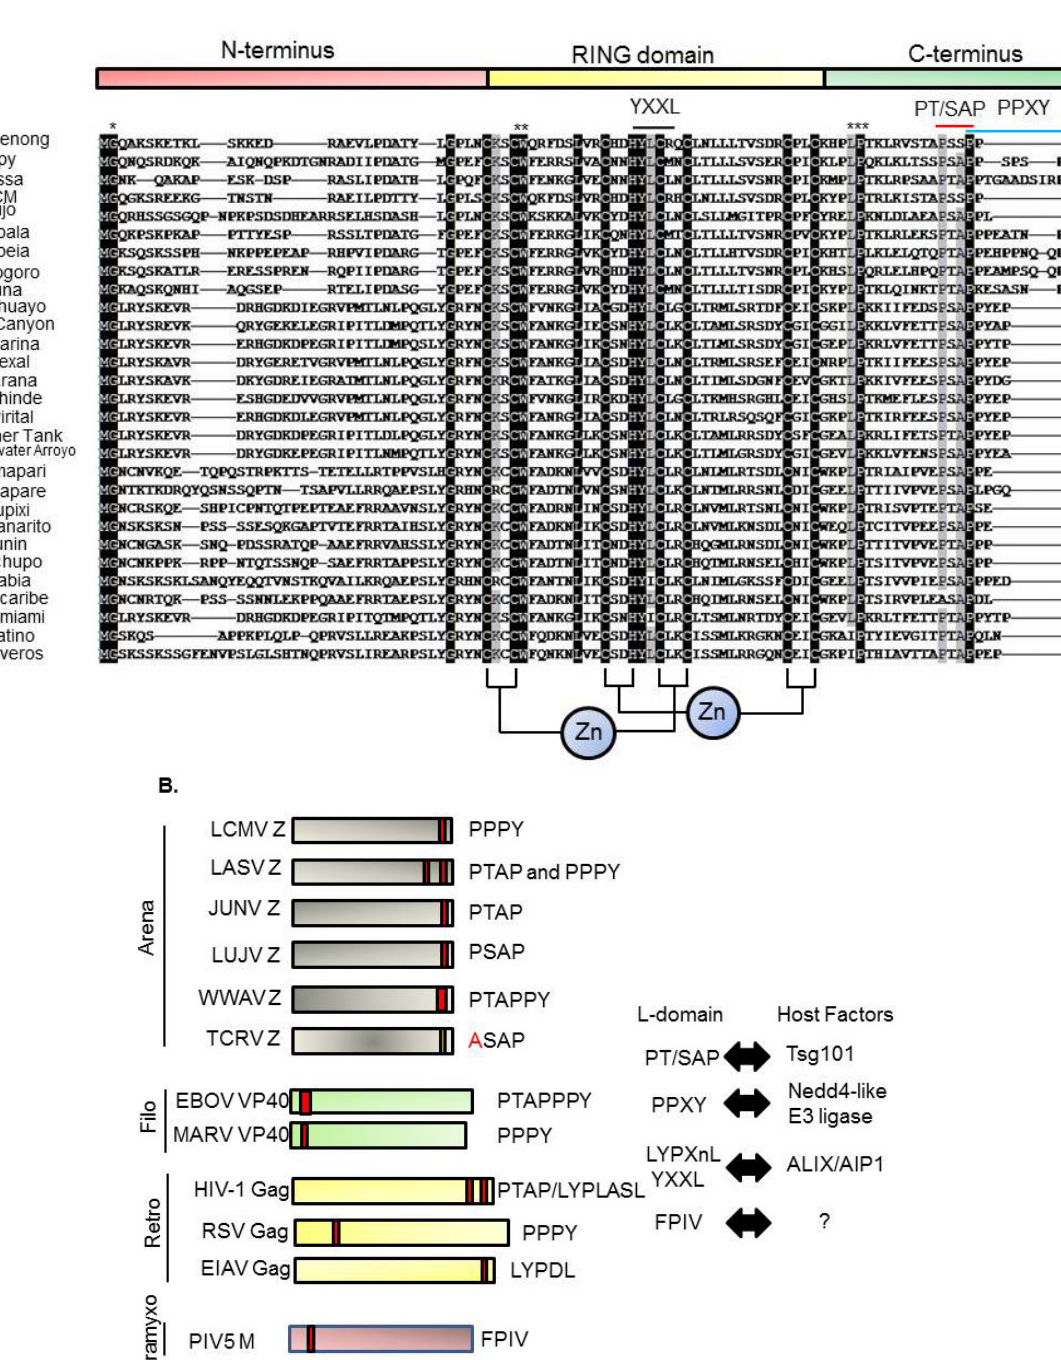
Figure 4. Alignment of amino acid sequences of arenavirus Z proteins. ( A ) The Z proteins are arranged by clade using ClustalW. N-terminus, central RING domain, C-terminus as well as L-domains are indicated above. Arenavirus clades are indicated on left. Conserved zinc motifs are indicated below the alignment. * shows conserved myristoylation site glycine 2 (G2), ** tryptophan (W), *** proline (P). Black box indicates 100% match and gray box indicates 90% match of amino acid among the Z proteins. ( B ) L-domains within matrix proteins of enveloped viruses. L-domains and their interacting host factors are indicated. Accession numbers for reference sequences are described in the legend of Figure